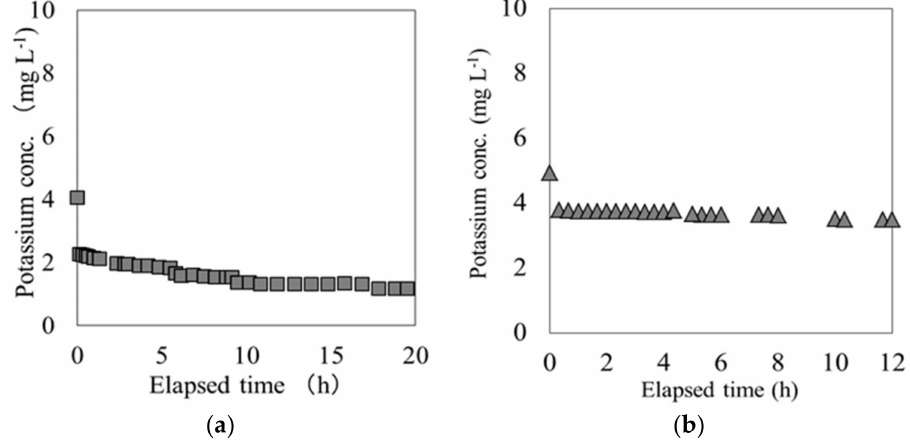
Figure 6. K elution from ( a ) carbonized rice hull and ( b ) beech sawdust in the breakthrough